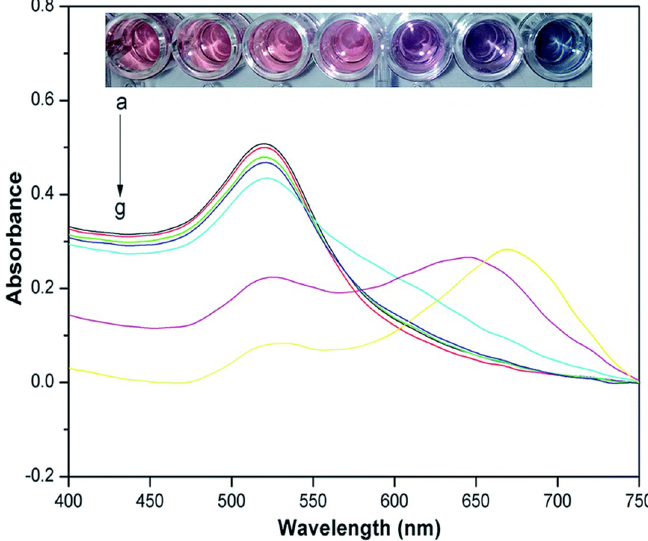
Figure 4. Changes in the colors and UV-visible spectra of a cysteamine–gold nanoparticle solution with different concentrations of atrazine. Reproduced with permission from reference [55].